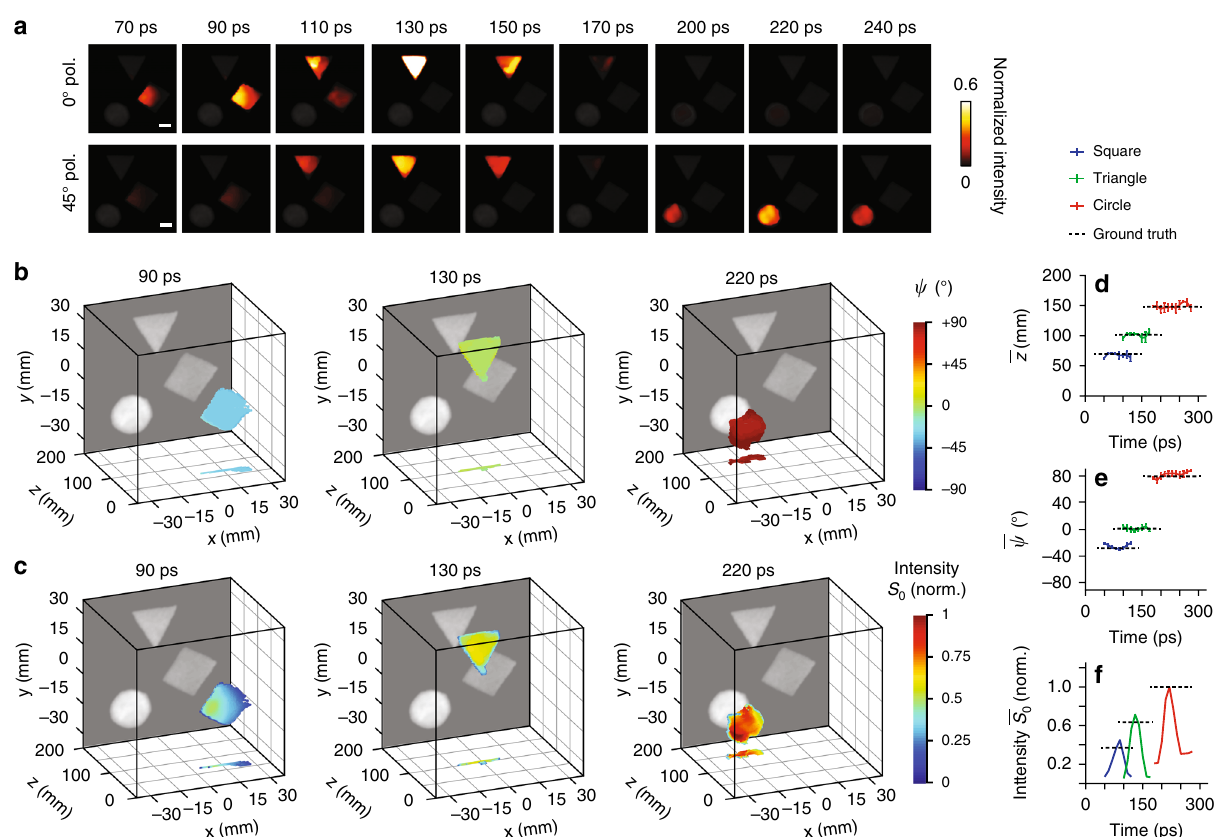
Fig. 4 Stereo-polarimetric ultrafast ( x, y, z, t, ψ ) imaging using SP-CUP. a Nine representative frames of the ultrafast dynamics imaged at 100 Gfps using Views 1, 3, and 4 (top row) through the 0 o polarizers and Views 2, 5, and 6 (bottom row) thr o ugh the 45 o polarizers. The full evolution is in Supplementary Movie 4. b – c Reconstructed AoLP ( ψ ) b and the fi rst Stokes parameter ( S 0 ) c in 3D space at three representative frames: 90 ps, 130 ps, and 220 ps. A relative depth is used by setting the 600-mm depth as the origin. The back side of the plot is the time-unsheared image. The images on the x – z plane are the projections of the 3D plots along the y axis. d – f Averaged values of z d , ψ e and S 0 f of the three shapes versus time. The black dashed lines are the ground truths measured using the time-unsheared stereo images from the external CCD cameras (Views 1 and 2). Note that the fi nite lengths of these dashed lines are for illustration only and do not indicate durations of events. Scale bar in a , 10 mm. Error bars in d and e , standard